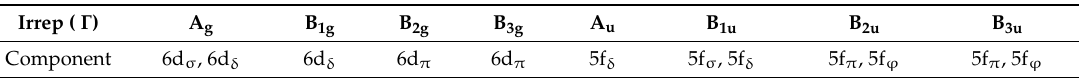
Figure 1. QTAIM derived an atomic basin of U in UCl 6 , which exhibits the full symmetry of the molecule. Figures reproduced from Reference [61]. Table 5. Irreducible representations spanned by components of the 5f and 6d valence shells with respect to the principal molecular axis.